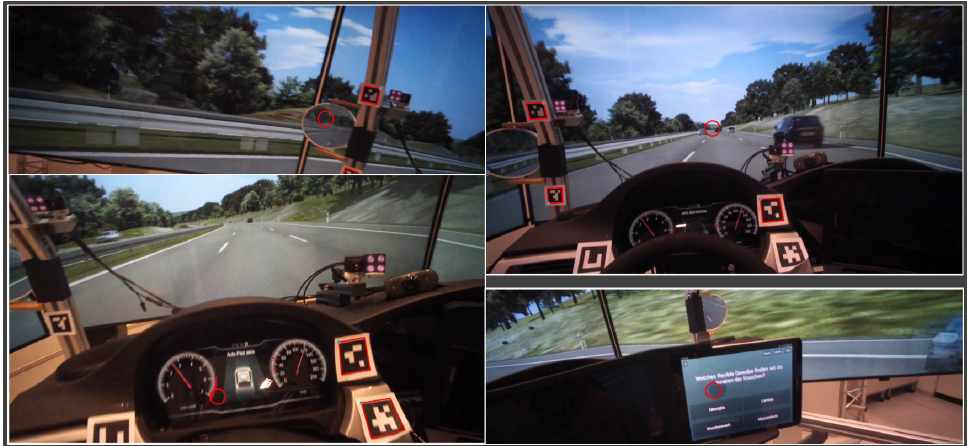
Figure 5. Depiction of the driving simulator study. Source: